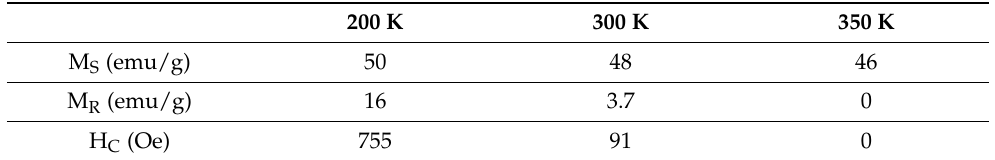
Figure 5 depicts the dielectric constant ( ε (cid:48) ) versus the frequency curve, showing the real part of the dielectric constant of CoFe 2 O 4 nanostructures measured at different temper- atures in the frequency range of 1.0 Hz to 10 MHz. The value of the dielectric constant was determined using the formula ε (cid:48) = C p × d / ε , where d is the thickness of the pellet, C p 0 × A